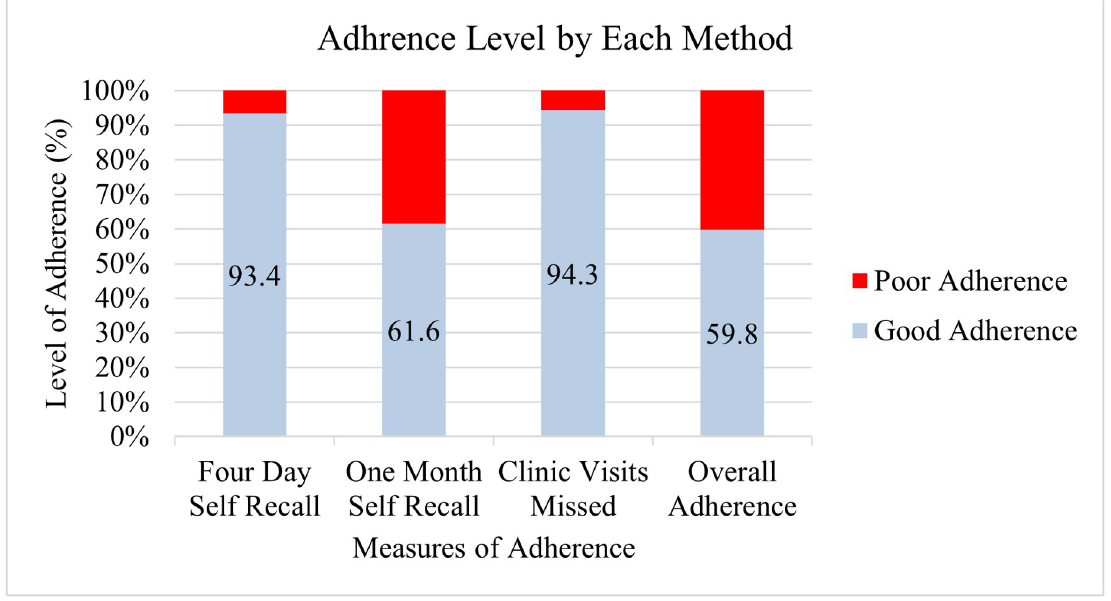
Fig 3. Adherence level By each method of adherence